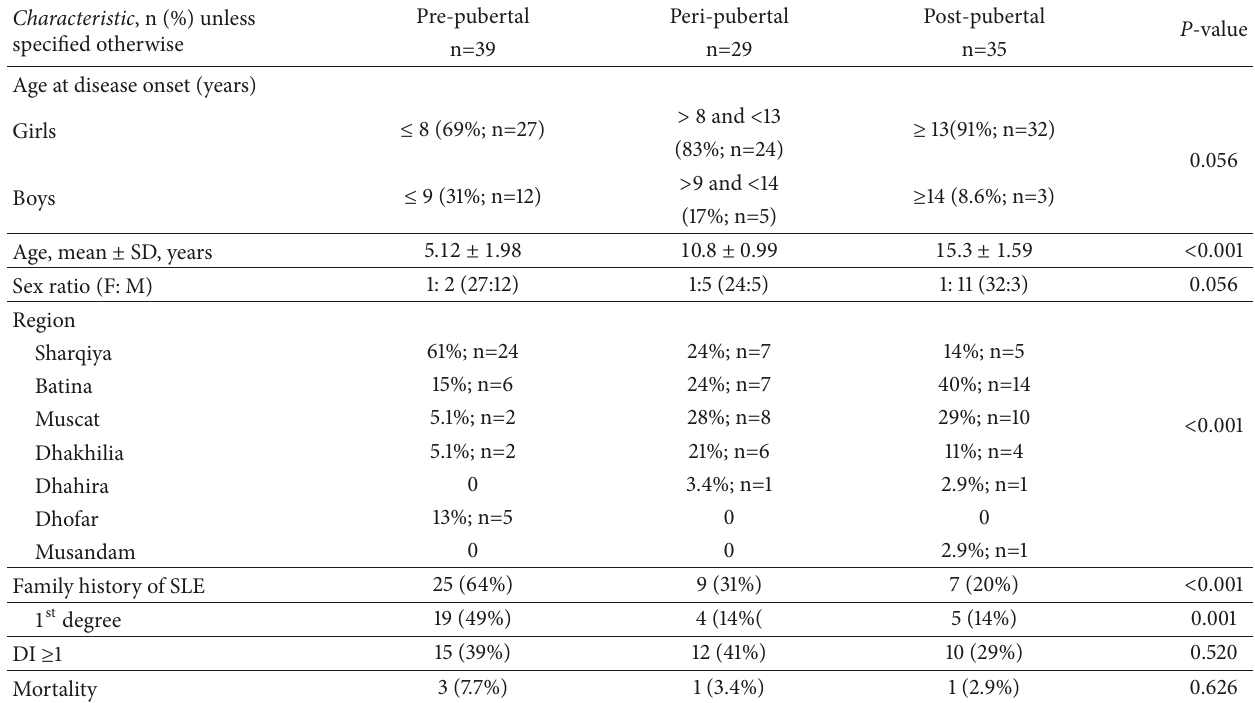
Table 1: Characteristics and outcomes of systemic lupus erythematosus (SLE) patients according to age at onset of disease. Characteristic , n (%)